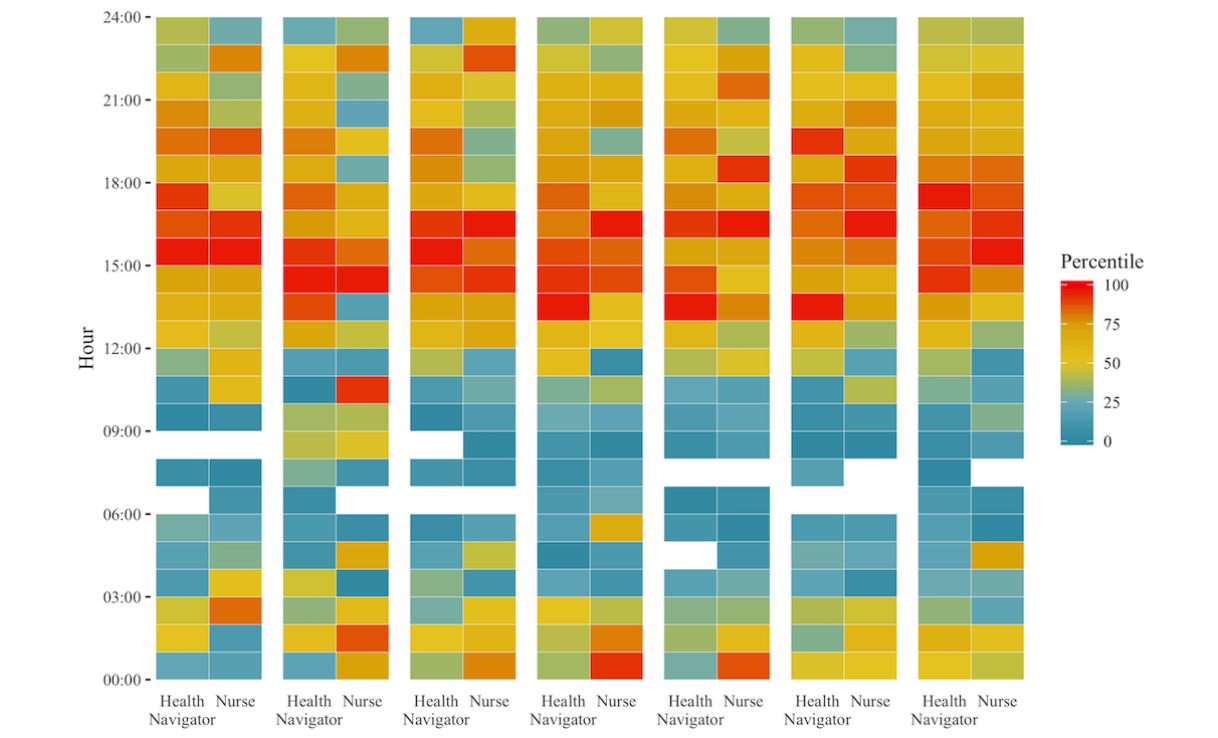
Figure 5. Time of communications by day, shift, and staff role for March 2016 to January 2017. Each week is separated by hours scored by percentile of conversations for that hour. The percentile of conversations (0 corresponding with 0 conversations for that hour) for health navigators and nurses are plotted for each hour in each day. The largest concentration of conversations with health navigators was Mondays between 14:00-15:00; with nurses, it was Sundays between